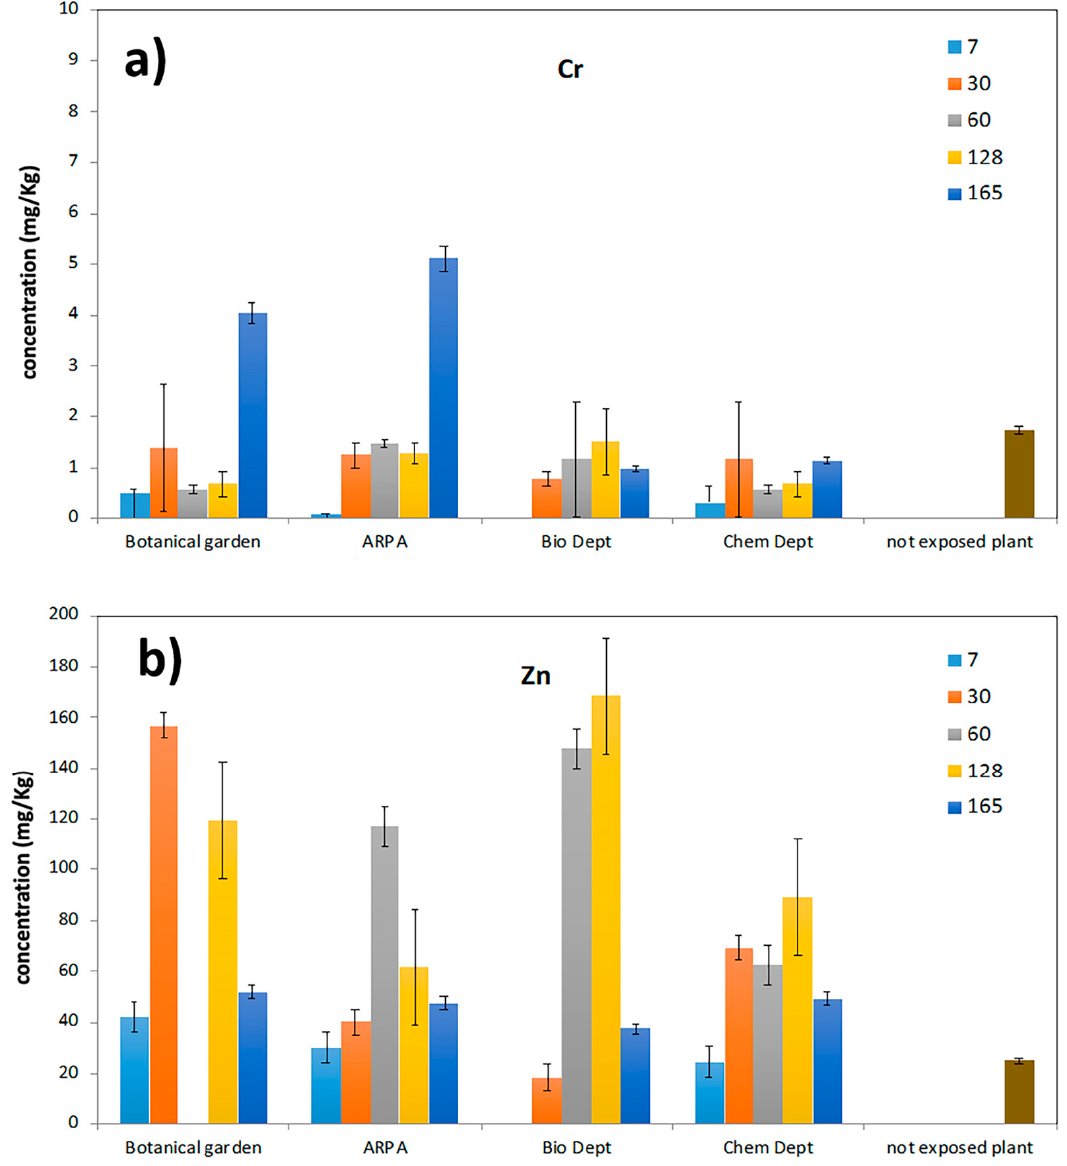
Figure 3. Concentrations trends for Cr ( a ) and Zn ( b ) in the Chlorophytum comosum analyzed samples in the different sites in Milan and for different exposure times (7, 30, 60, 128 and 165 days); the concentrations determined for the not-exposed plant have been added for both metals (reported in brown